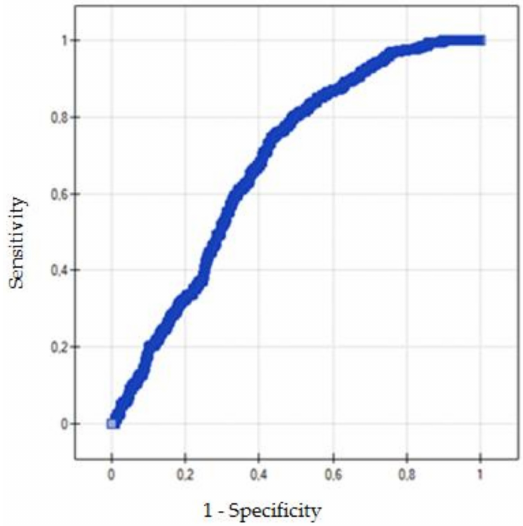
Figure 3. The ROC curve for the